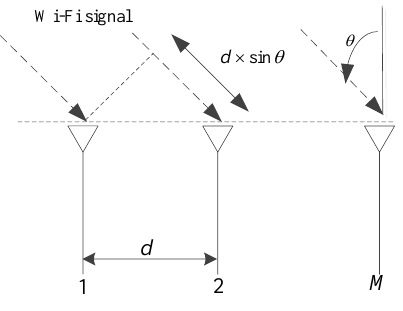
Figure 1. Wi-Fi signal arriving at linear antenna